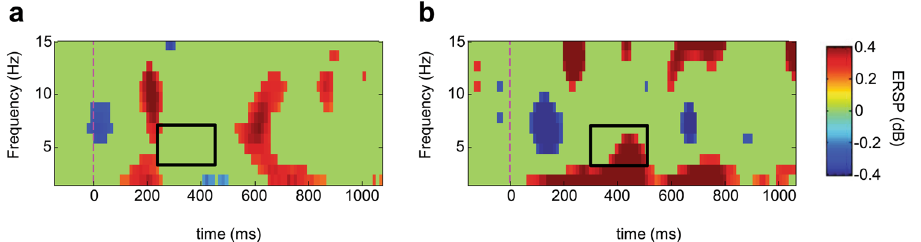
Figure 3. Log transformed event-related spectral perturbations of the related (left) and unrelated (right) words. Only significant changes (p < 0.05) from the baseline period ( − 200 to 0 ms relative to word onset) are colored other than green. Theta activity (3–7 Hz) was significantly increased in the unrelated compared to the related condition in the N400 time range (boxed areas; t (1,84) = 3.1, p = 0.002).